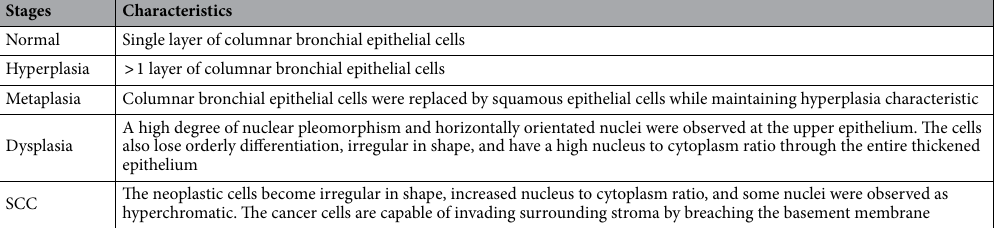
Table 3. Description for each stage of lung SCC histology characteristics.